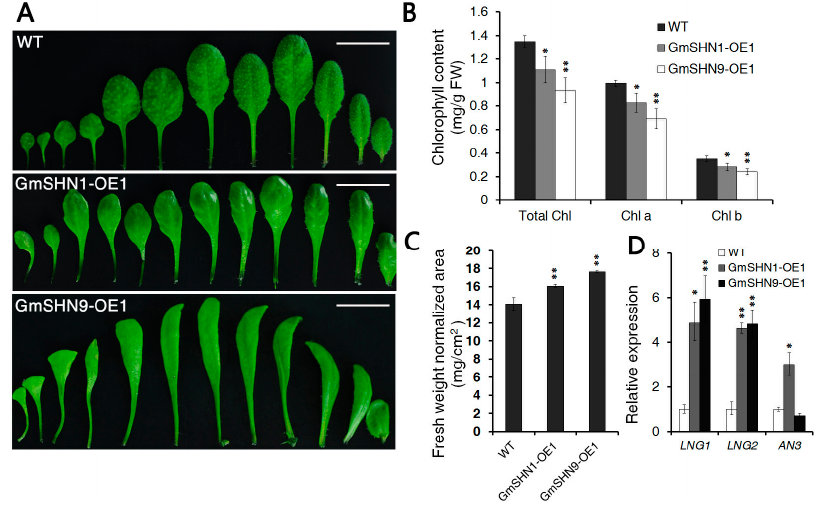
Figure 5. Morphological and biological analysis of transgenic plants. ( A ) Anatomy analysis of 4-week-old Arabidopsis rosette leaves of WT, GmSHN1-OE1 and GmSHN9-OE1. GmSHN1-OE1 had smaller leaves, and GmSHN9-OE1 exhibited yellow-green, longer, and more slender leaves. We performed three independent assays and received similar results each time; ( B ) Analysis of total chlorophyll (total Chl), chlorophyll a (Chl a) and chlorophyll b (Chl b) in GmSHN1-OE1, GmSHN9-OE1, and WT leaves. Presented values are means from three independent replicates (±SD); ( C ) Analysis of leaf fresh weight normalized area of GmSHN1-OE1, GmSHN9-OE1, and WT. Leaf fresh weight normalized area (mg/cm 2 ) increased 14% in GmSHN1-OE1 and 25% in GmSHN9-OE1. The data are given as mean values with ±SD ( n = 3); ( D ) Expression of leaf development related genes. Expression levels of genes in WT were taken as 1. The Arabidopsis ACT2 gene was used as the internal control for normalization of the template cDNAs. The results are given as mean values of three replicates, and error bars represent SD ( n = 3). * p < 0.05, ** p < 0.01 vs. WT with two tailed Student’s t test.